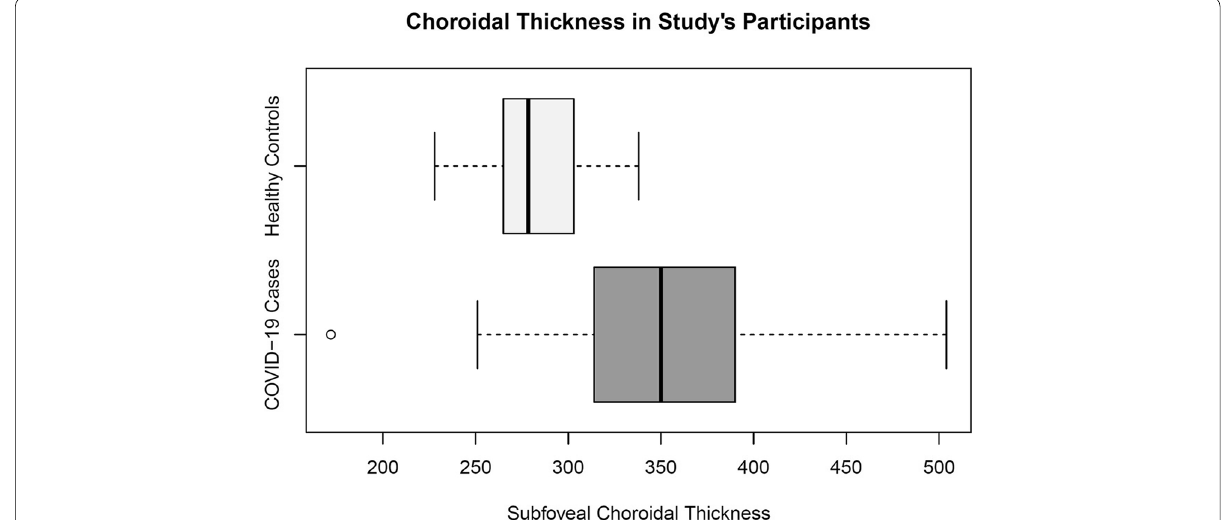
Fig. 4 Box plots depict choroidal thickness in COVID‑19 patients and healthy